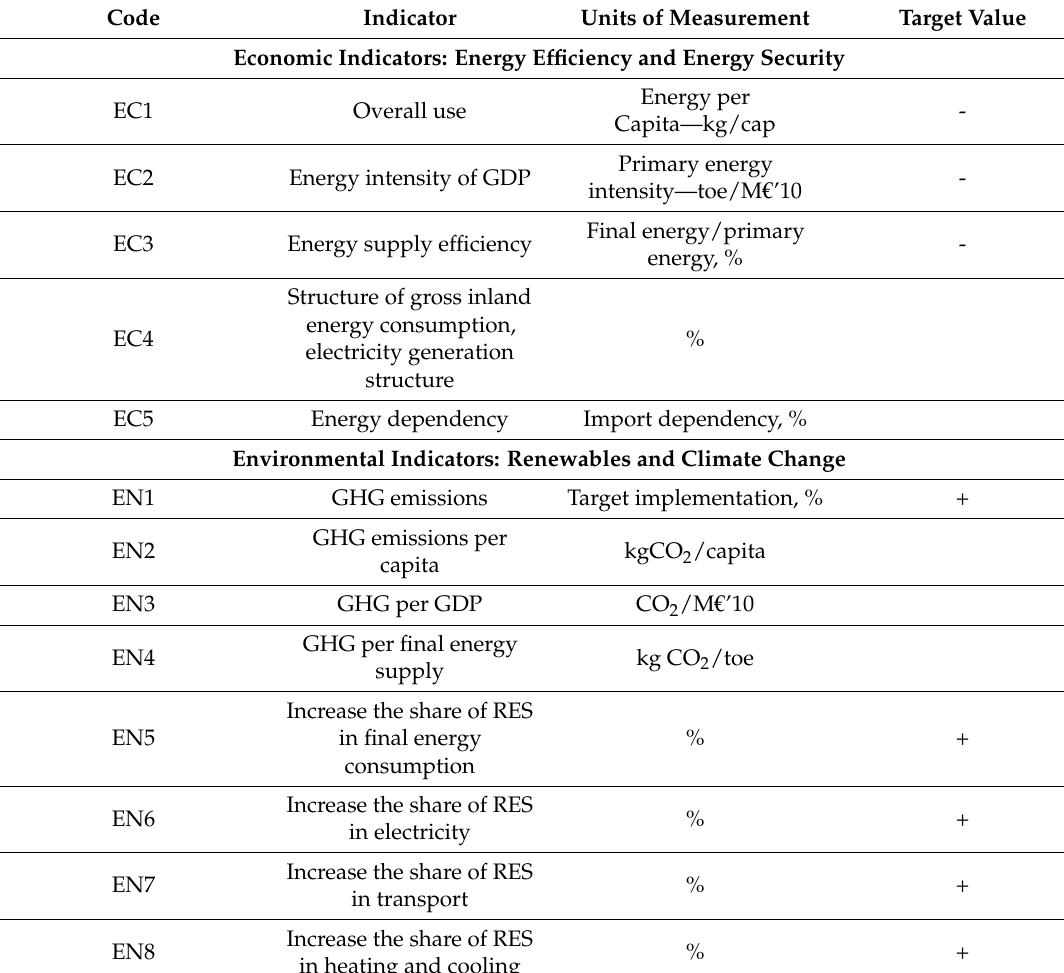
Table 2. Set of the indicators for assessment of GHG profiles. Source: created by authors based on [38].